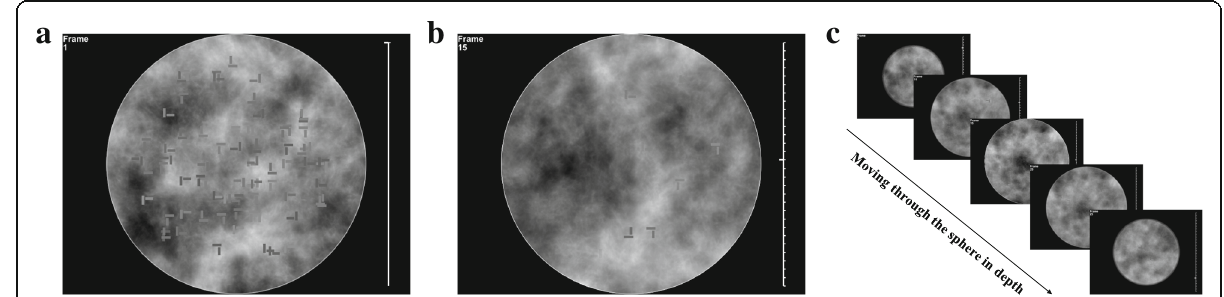
Fig. 3 Experiment 2 ’ s 2D and segmented-3D search displays. a Sample stimuli of a 2D-search display where all search items appear in a single “ flat ” plane. b Sample stimuli of a slice in the segmented-3D-search display. Search items were randomly assigned to each slice, and unlike in the 2D display, did not all appear on the same depth plane. c Illustration of how participants could move from slice-to-slice to search in depth in